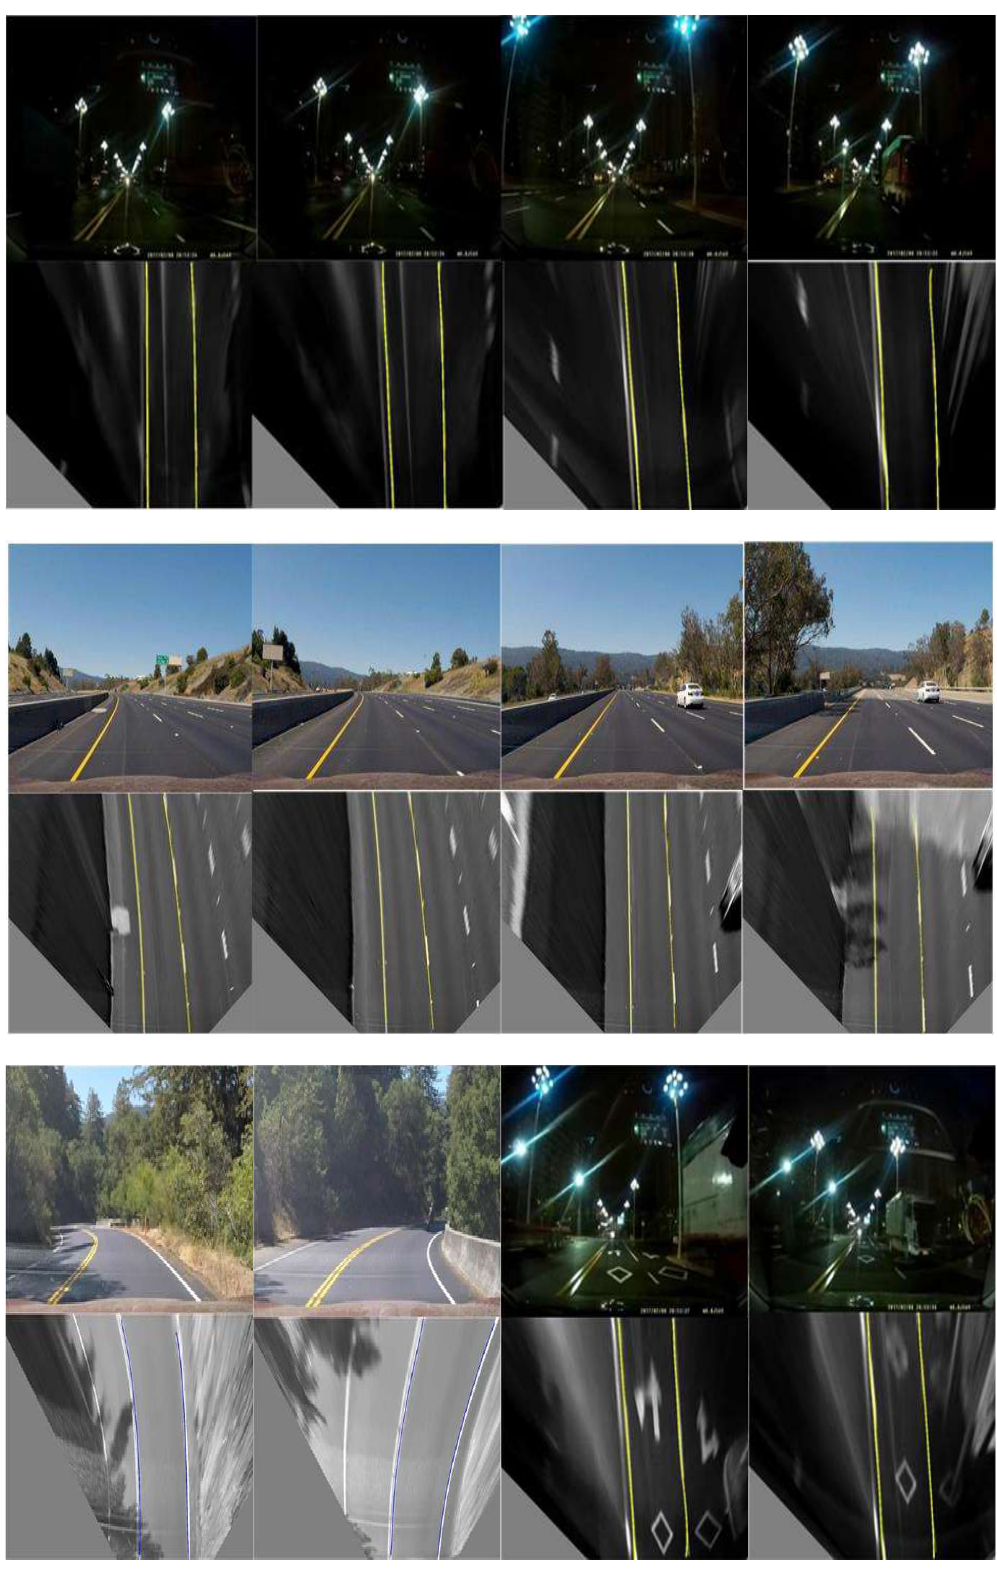
Figure 17. Detection results of other data sets.